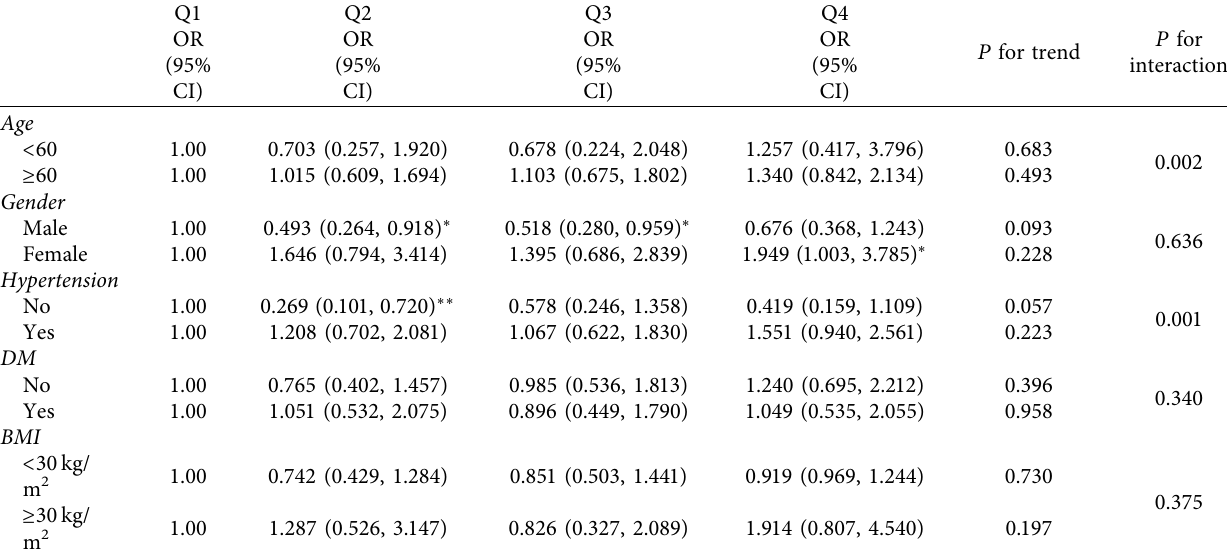
Table 5: Subgroups analysis for the associations of serum 25(OH)D with the prevalence of SAAC. Q1